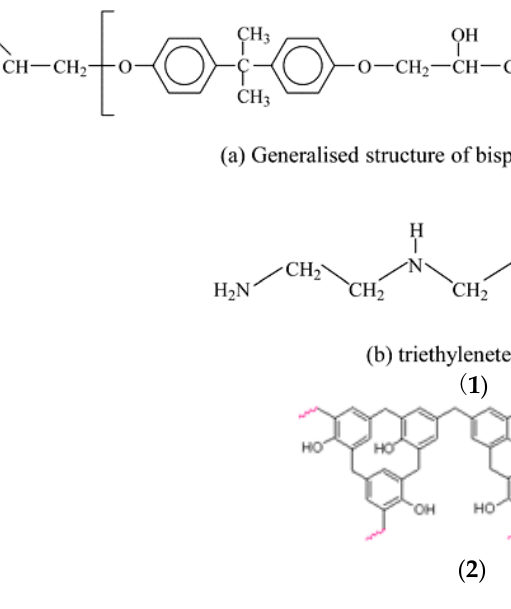
Figure 4. Structures of thermosets: ( 1 ) epoxy resin, a. resin, b. hardener; ( 2 ) cross-linked Bakelite.